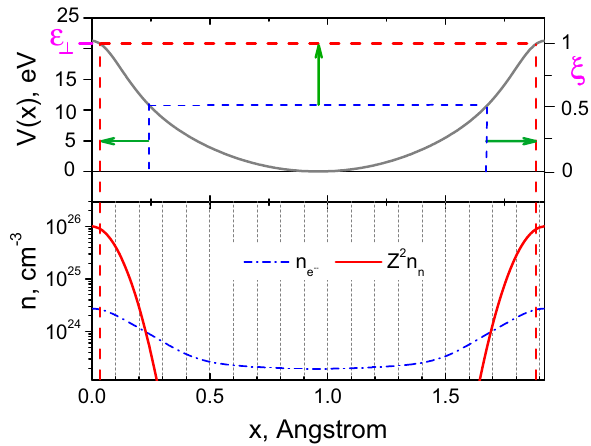
Fig. 1 Planarpotentialandtheundertakenexpansionoftheconsidered region of positively charged particle motion, shown by arrows ( top ). Averaged number density of electrons and the same, multiplied by the atomic number squared, of nuclei ( bottom )